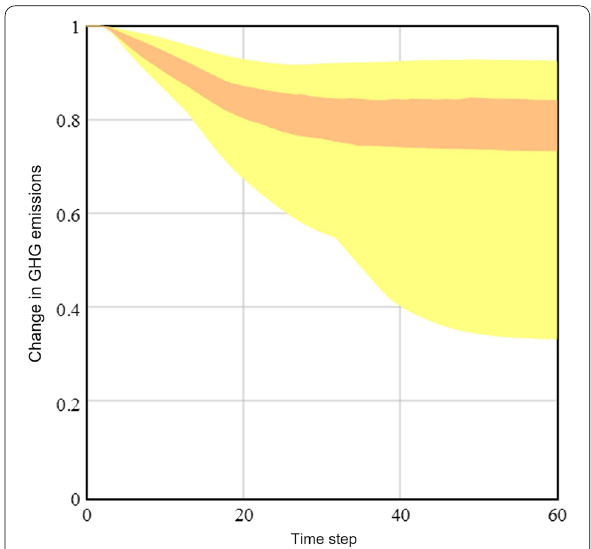
Fig. 6 Full set of interventions under random sampling of all weights. Yellow: 100% range. Orange: 50% range